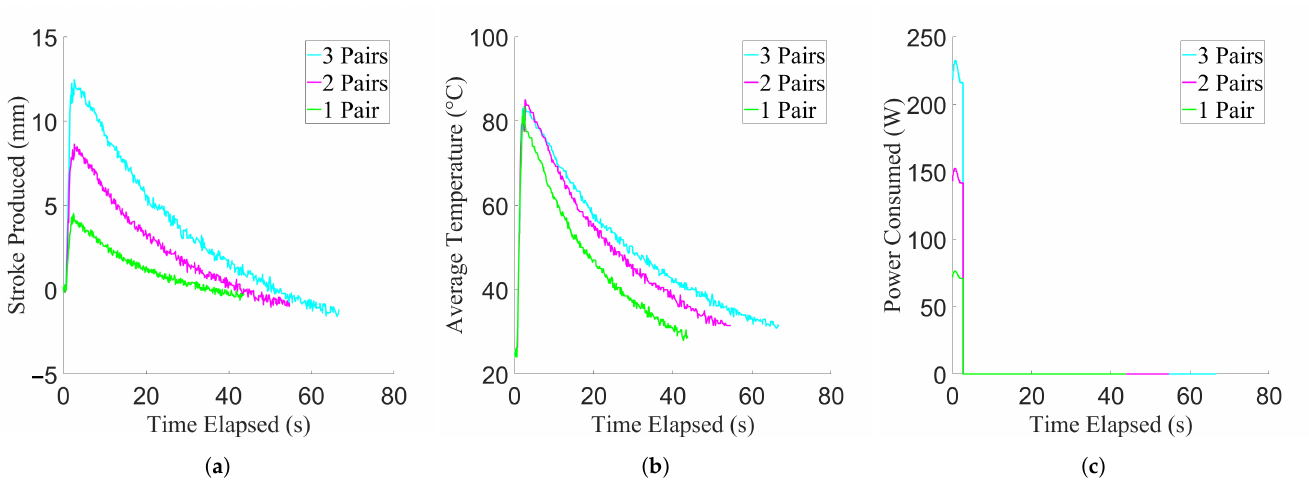
Figure 14. Results of the minimum contraction period experiment, showing data from example trials. For the purpose of clarity, example curves were used due to low variance between trials. ( a ) Stroke production of the actuator. ( b ) Temperature achieved by the actuator. ( c ) Power consumed by the actuator.